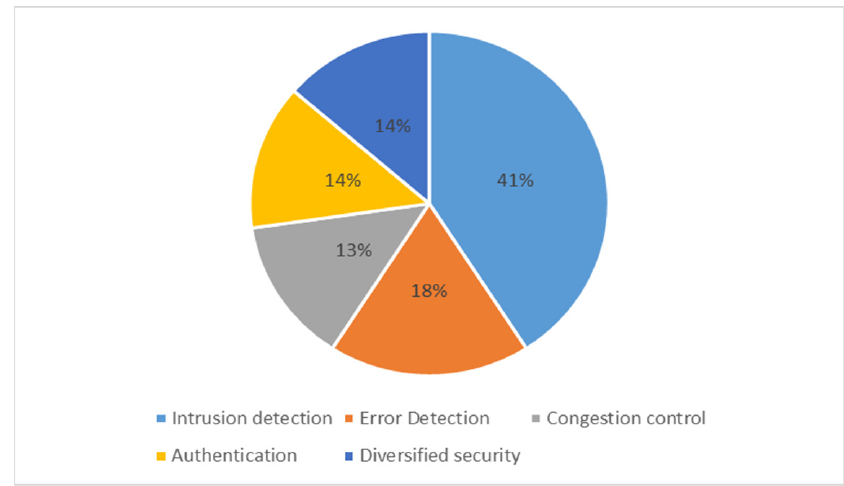
Figure 12. Statistical analysis for the reviewed ML algorithms in WSN security.